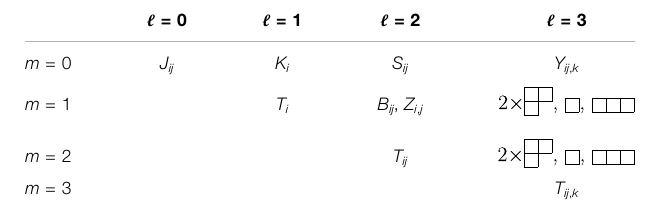
TABLE 2 | The fi rst few levels of the free Lie algebra generated by Carroll. The double-grading ( ℓ , m ) isexplainedin the text, as isthe relation betweenYoung diagrams and comma-separated index